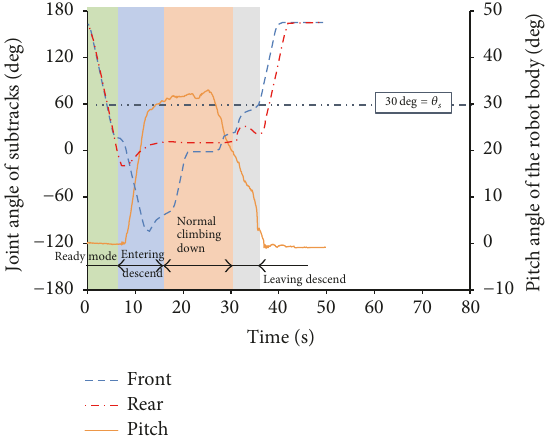
Figure27:Dataprofilefor 𝜃 𝑓 , 𝜃 𝑟 , 𝜃 𝑝 ( 𝜃 𝑠 =30 ∘ , 𝑝 =200 mm,descend).